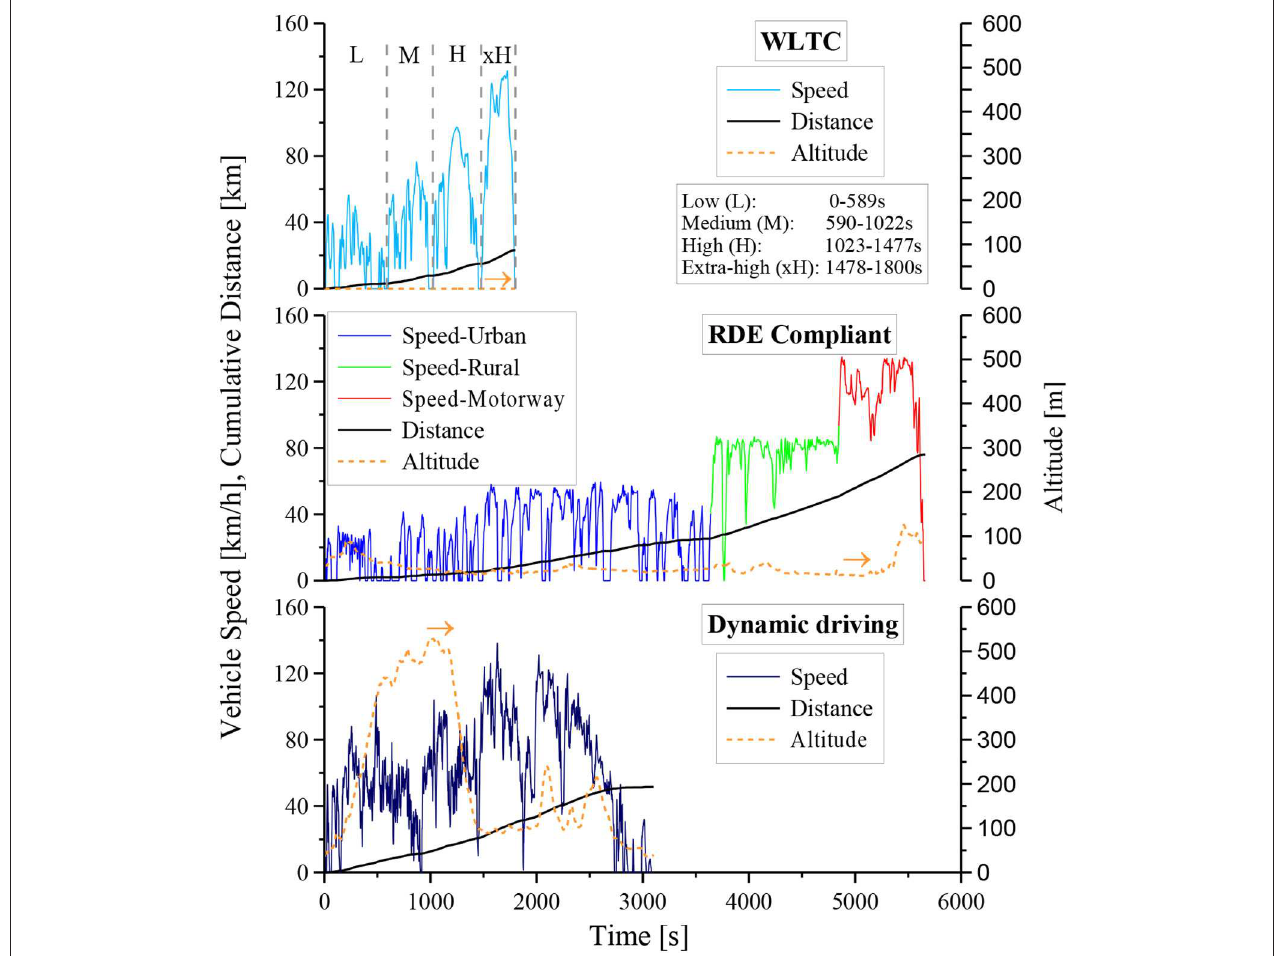
FIGURE 2 | Vehicle speed, cumulative distance, and altitude for the WLTC, the RDE-compliant, and the Dynamic driving